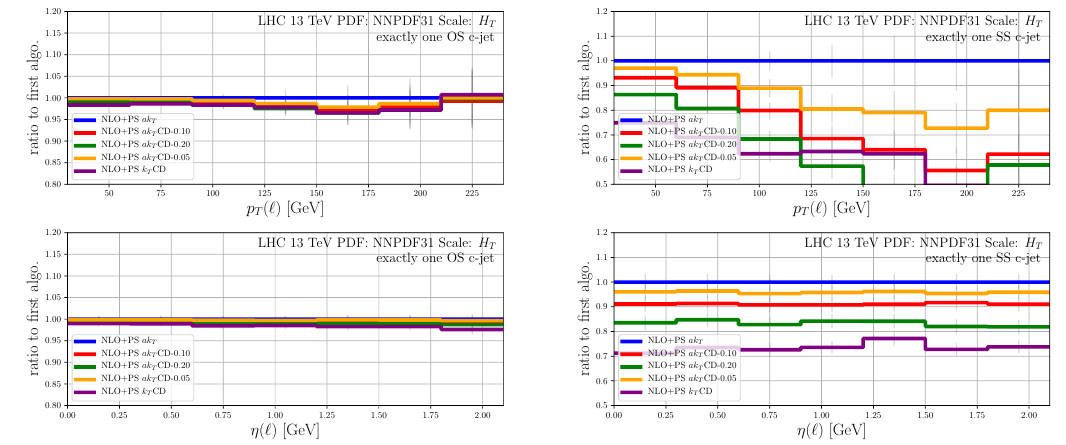
Figure 10 . As in figure 9 but showing exactly one OS c-jet (left) and exactly one SS c-jet (right).